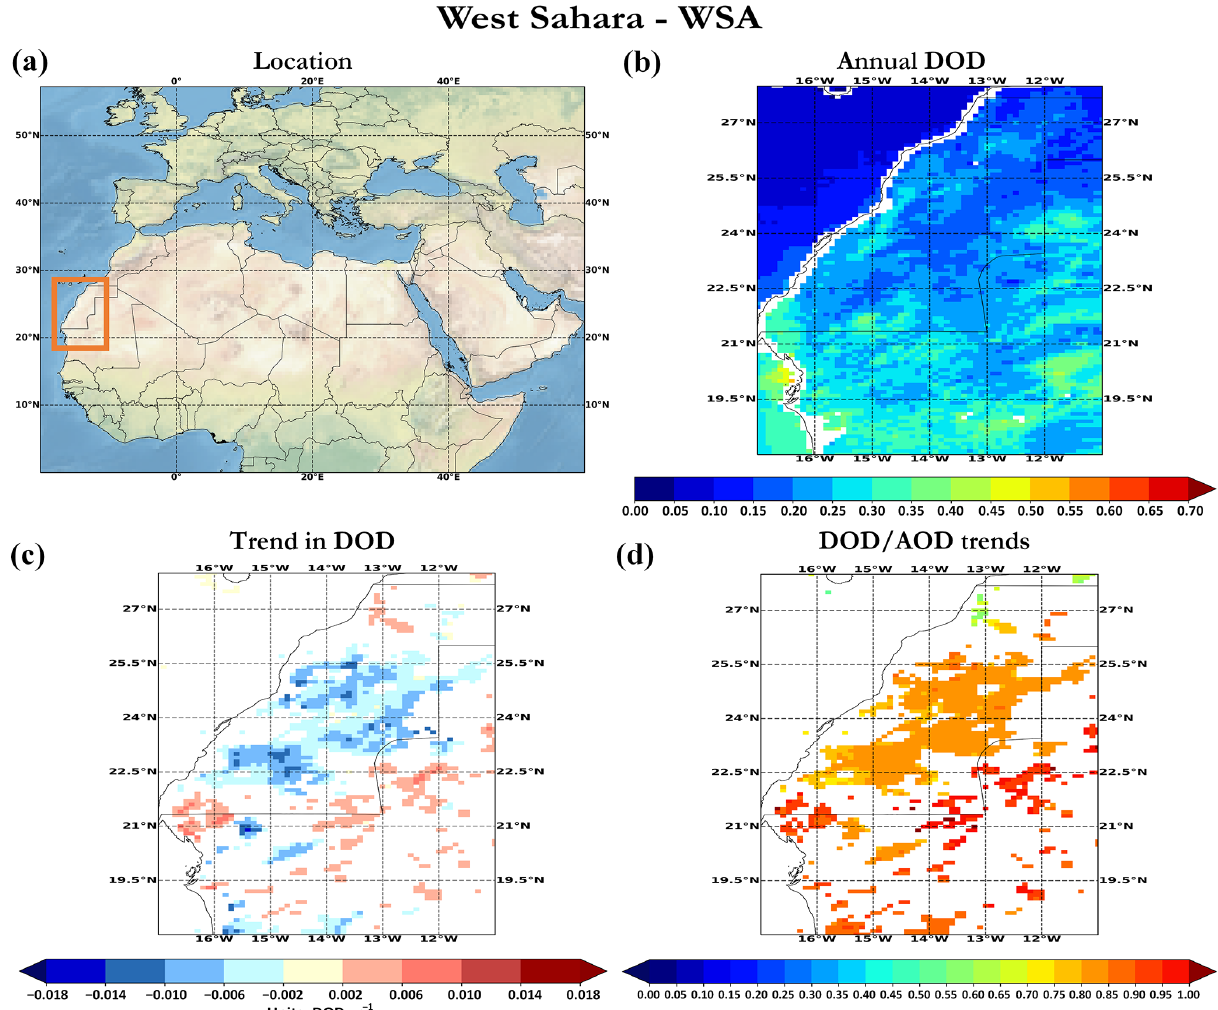
Figure 11. Same as Fig. 10, but for the western